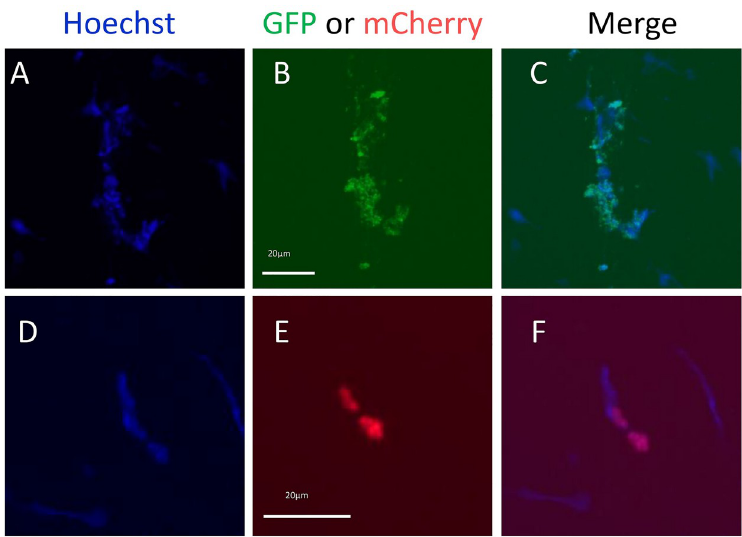
Fig 4. Coelomocytes lipofected with mRNA encoding GFP or mCherry result in very few examples of fluorescent cells. (A-C) Coelomocytes lipofected with GFP sense strand mRNA. (D-F) Coelomocytes lipofected with mCherry sense strand mRNA. (B) Selected coelomocytes show GFP green fluorescence. (E) Selected coelomocytes show mCherry fluorescence. The scale bar in (B) applies to panels (A) and (C). The scale bar in (E) applies to panels (D) and (F). Results for all fluorescent cell instances and controls are shown in Table